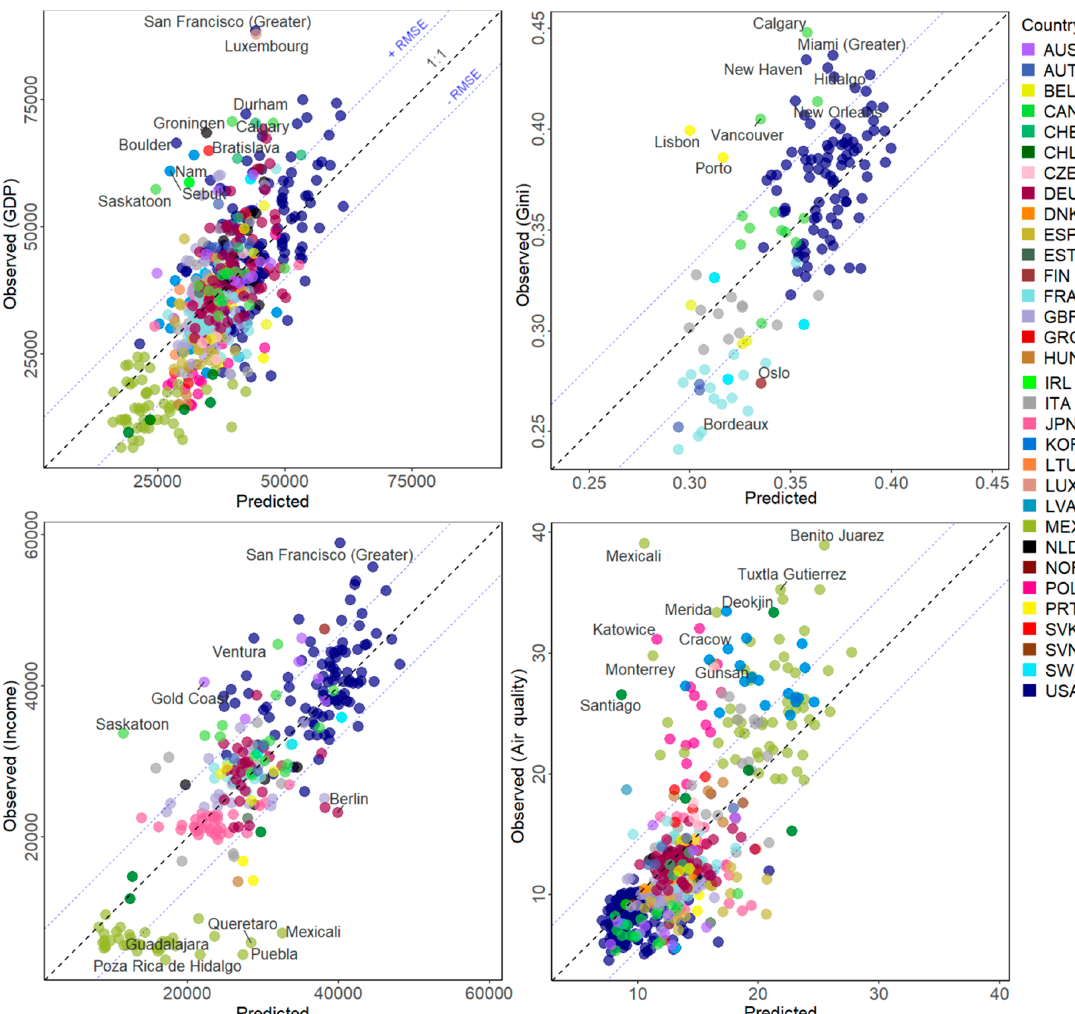
Figure 3. Observed versus predicted variables in mono-temporal models. The more the FUAs, represented as points, that are closer to the 1:1 line, the better the estimation by the model. The black dashed lines show the 1:1 lines (lines of perfect fit), while the blue dashed lines show the root mean square error of the model ( ± RMSE). The labels for the FUAs with the highest errors are shown, to identify outliers. The color represents the country. The units are GDP and income, USD; Gini, ratio; and air quality, PM2.5 in µg/m³.